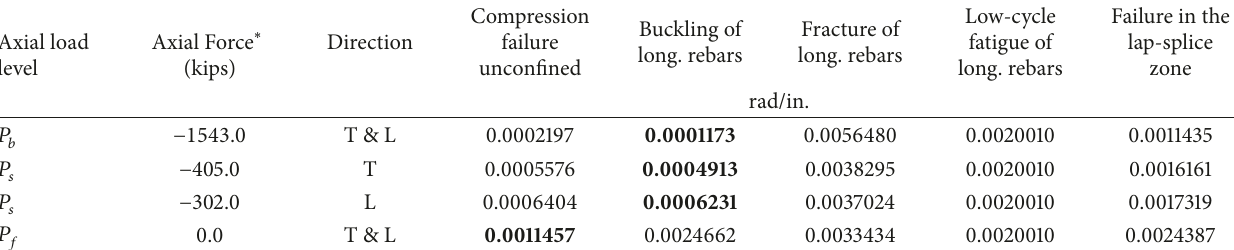
Table 10: Plastic curvature capacity of Pier #2 columns, Bridge #2-E.